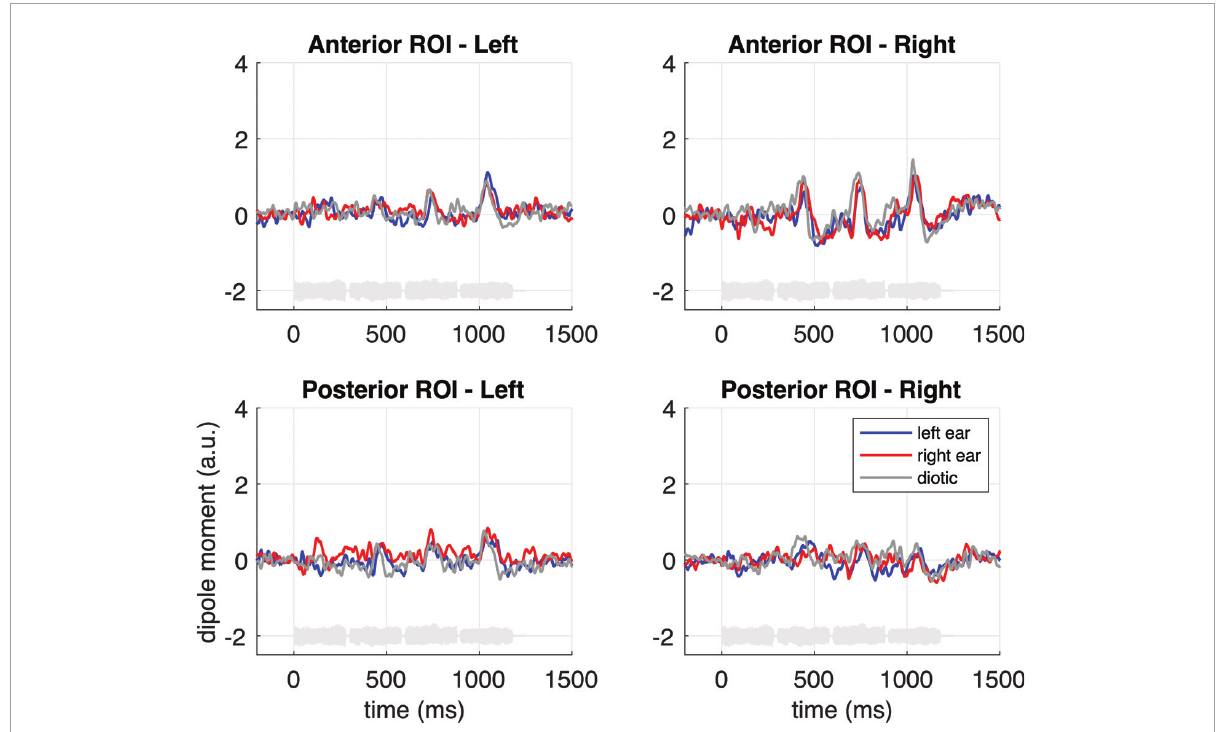
FIGURE5 Grand-average source waveforms from the anterior (top panels) and posterior (bottom panels) ROIs, shown as difference waveforms for the contrast of melodic contours and fixed pitch sequences. The light gray curves at the bottom of each subplot represent example sound waveforms from the